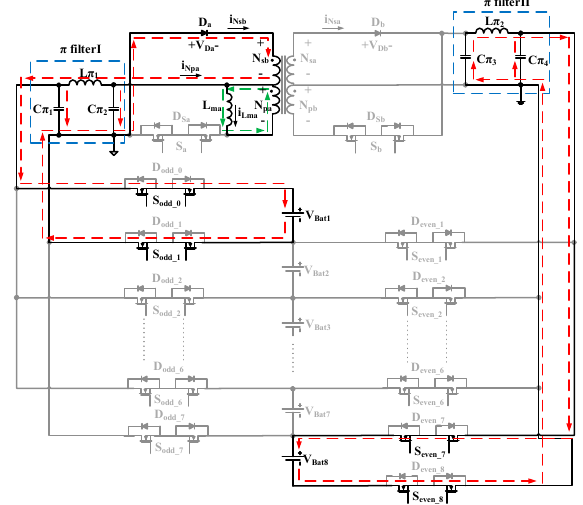
Figure 4. Mode II, the battery balancing process from higher V Bat1 to lower V Bat8 .